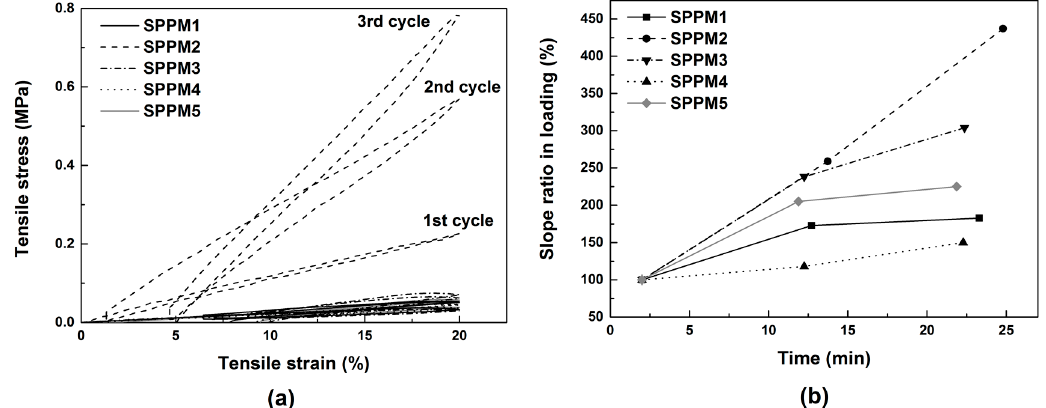
Figure 11. Evolution in the stress vs. strain relationship of all SPPM samples under cyclic uni-axial tension during crystallization induced hardening at 37 °C ( a ); and the slope ratios in loading at 20% strain in the loading process of each cycle as a function of testing time ( b ) (in which the slope of the stress vs. strain curve at 20% strain of the first cycle of each sample is taken as the reference).